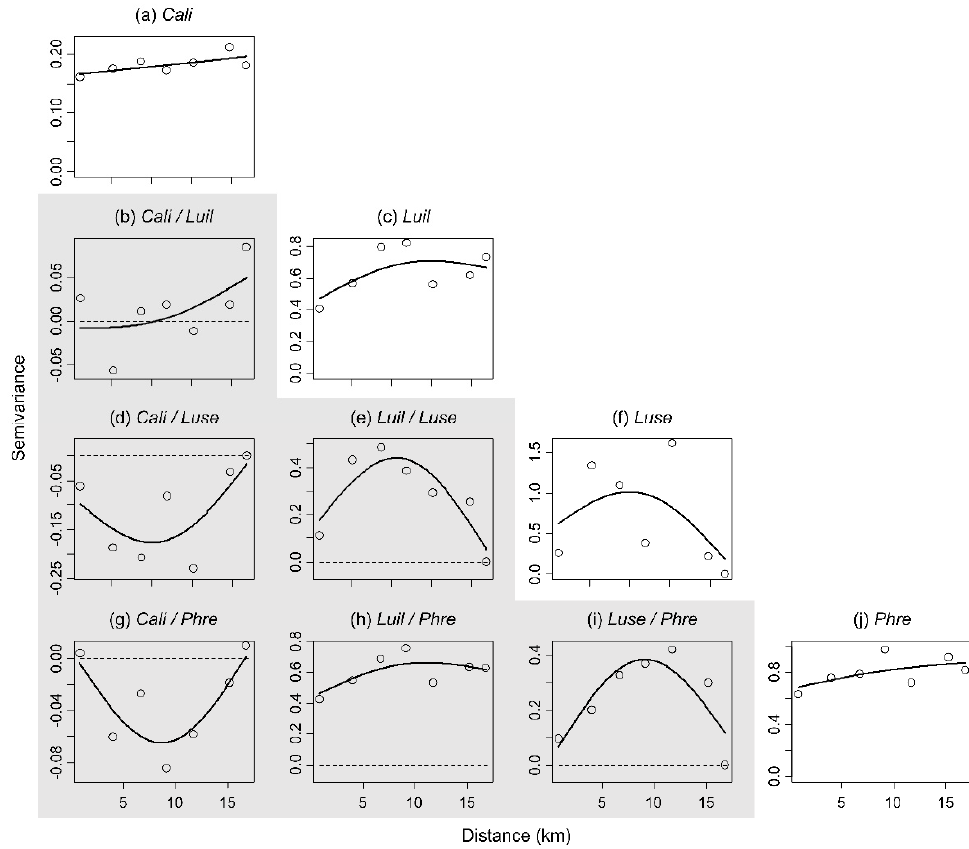
Figure 2. Semivariograms ( a , c , f , j ) and crossvariograms (gray area; b , d , e , g – i ) for the four most abundant Calliphoridae species during late summer 2019 in the Greater Moncton area, New Brunswick, Canada. Cali , Luil , Luse and Phre represent C. livida , L. illustris , L. sericata and P. regina , respectively. Data used to generate this figure are a subset of a previously published study [22].